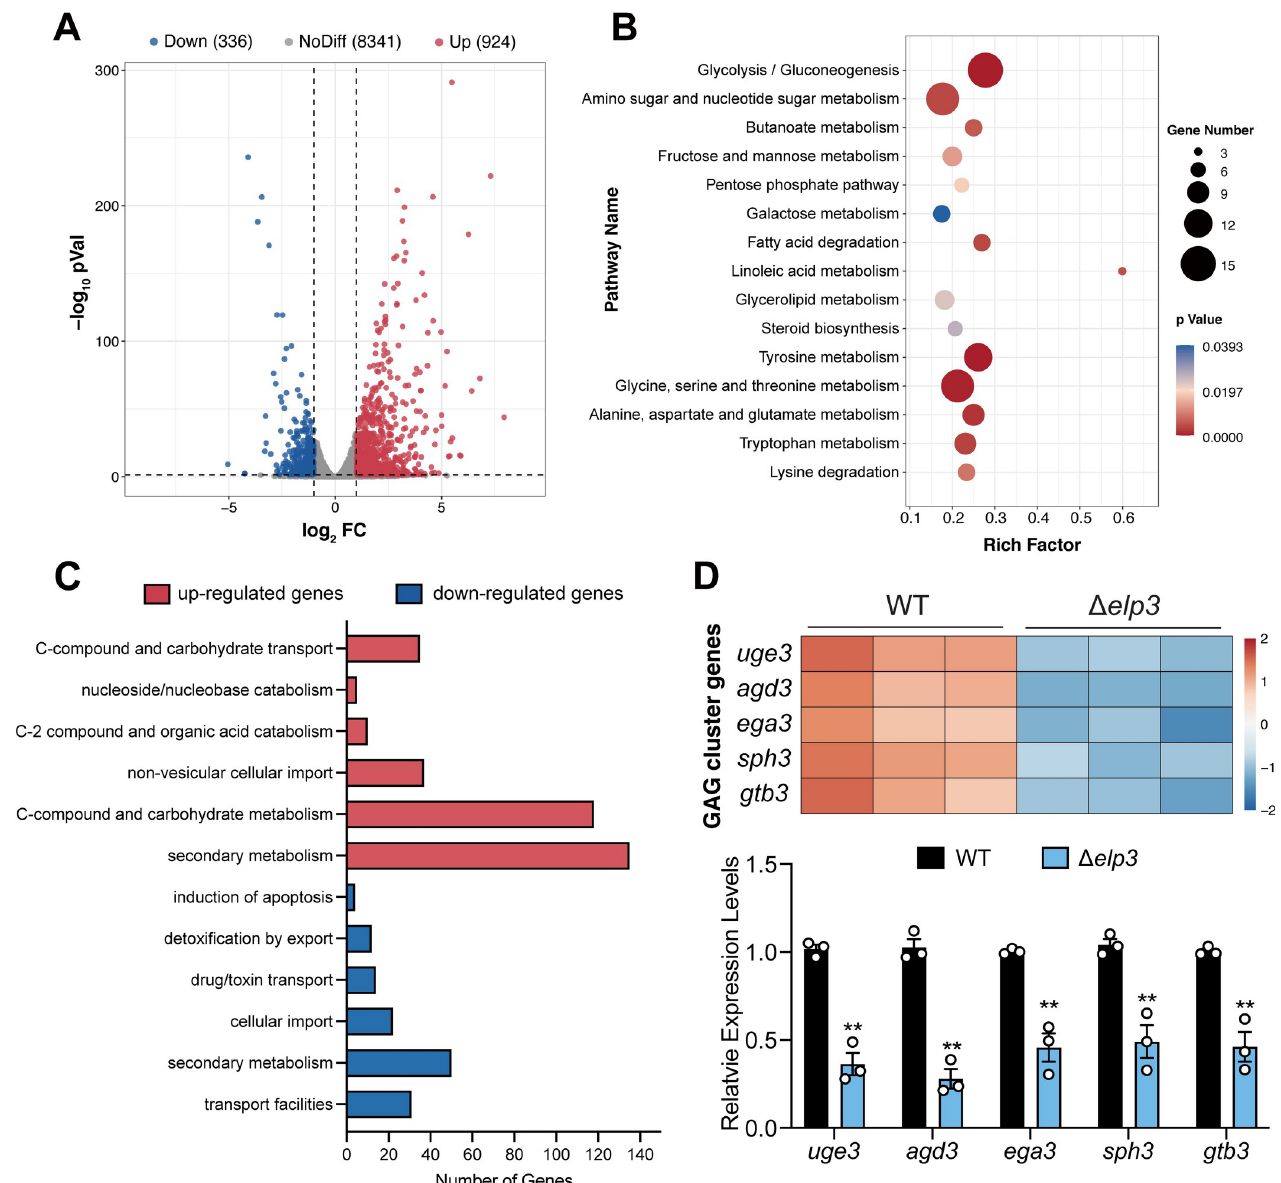
Fig 3. Loss of Elp3 alters the expression of genes involved in carbohydrate, lipid and amino acid metabolism and GAG biosynthesis. (A) Volcano plot showing the fold change and statistical significance of the differences in quantitative mRNA expression between the wild-type and Δ elp3 strains grown at 37˚C for 24 h. (B) KEGG pathway enrichment analysis of differentially expressed genes in the wild-type strain versus Δ elp3 mutant strain. (C) Gene ontology analysis of significantly upregulated and downregulated genes in the Δ elp3 mutant strain compared to the wild-type strain. (D) Heatmap of GAG cluster gene expression and quantitative real-time RT–PCR analysis of GAG cluster genes in the wild-type and Δ elp3 strains. The mRNA levels were normalized to that of the reference gene tubA . The data are presented as the mean ± SEM (standard error of the mean) of three independent experiments. Statistical analysis was performed using one-tailed, unpaired t tests. �� p <